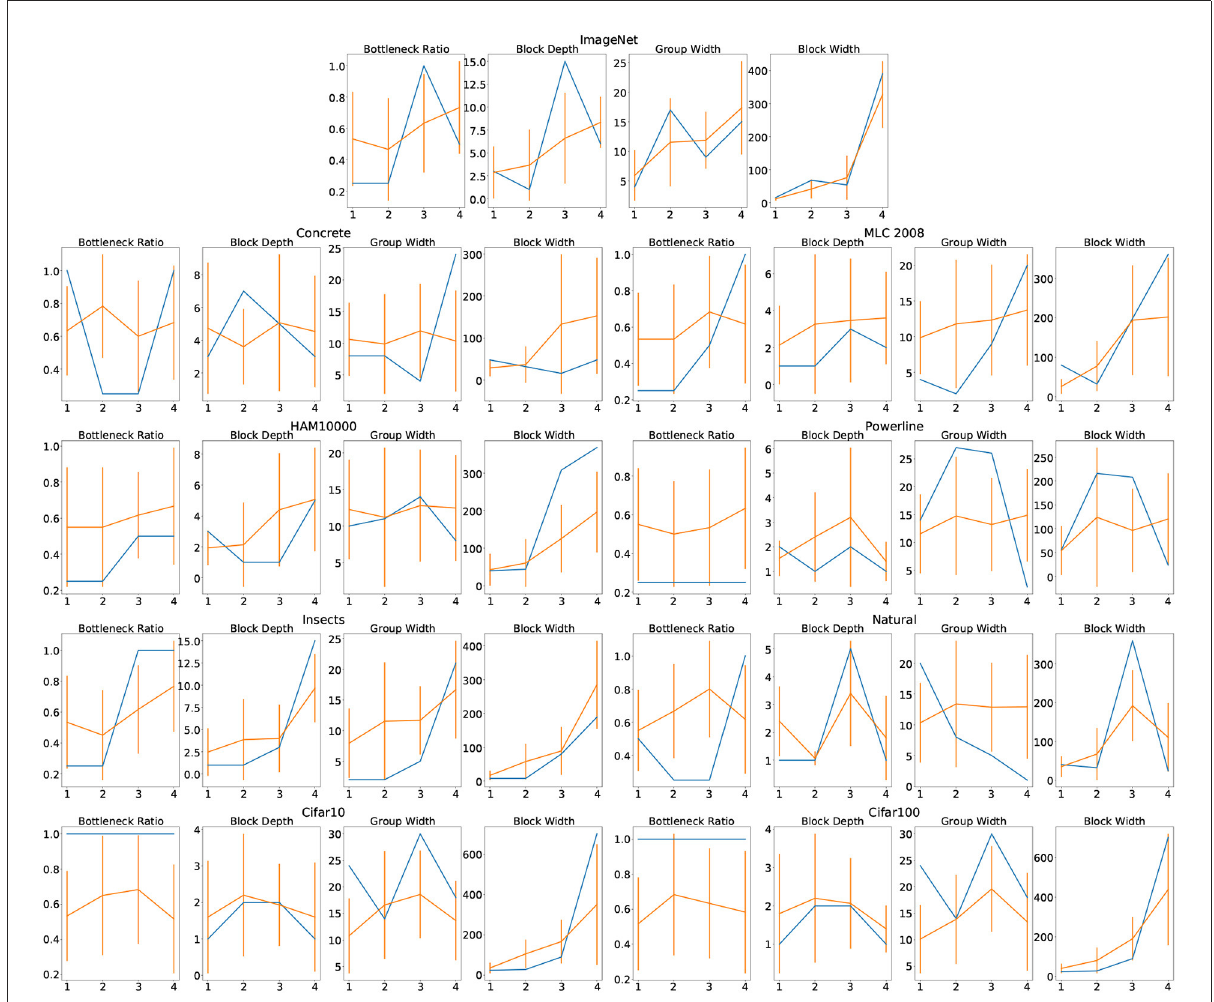
FIGUREA7 Configurations of the top-performing architectures, with the four stages depicted on the x-axis and the parameter values on the y-axis. The best architectures are shown in blue, the mean of the top 15 architectures is depicted in orange with with a vertical indication of one standard